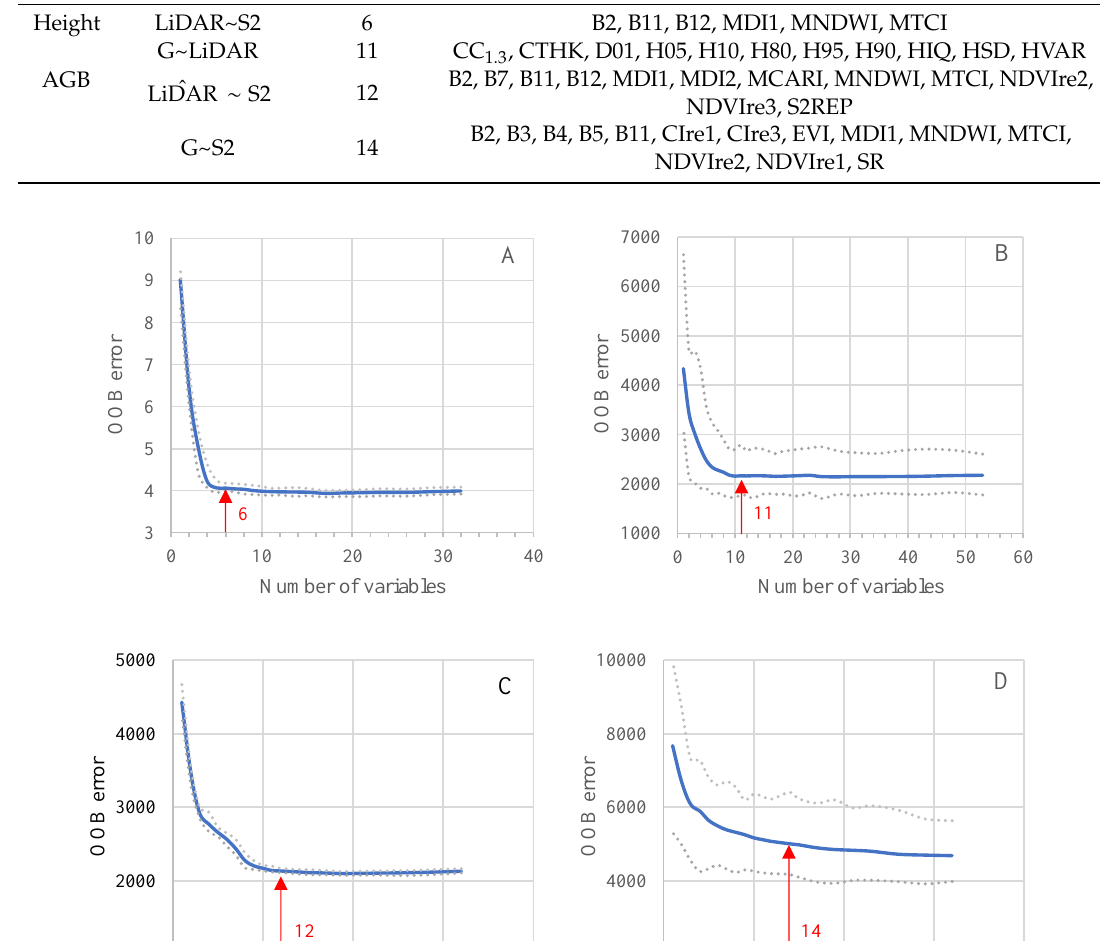
Table 3. The selected features from the RF-based backward feature elimination method. Selected Features